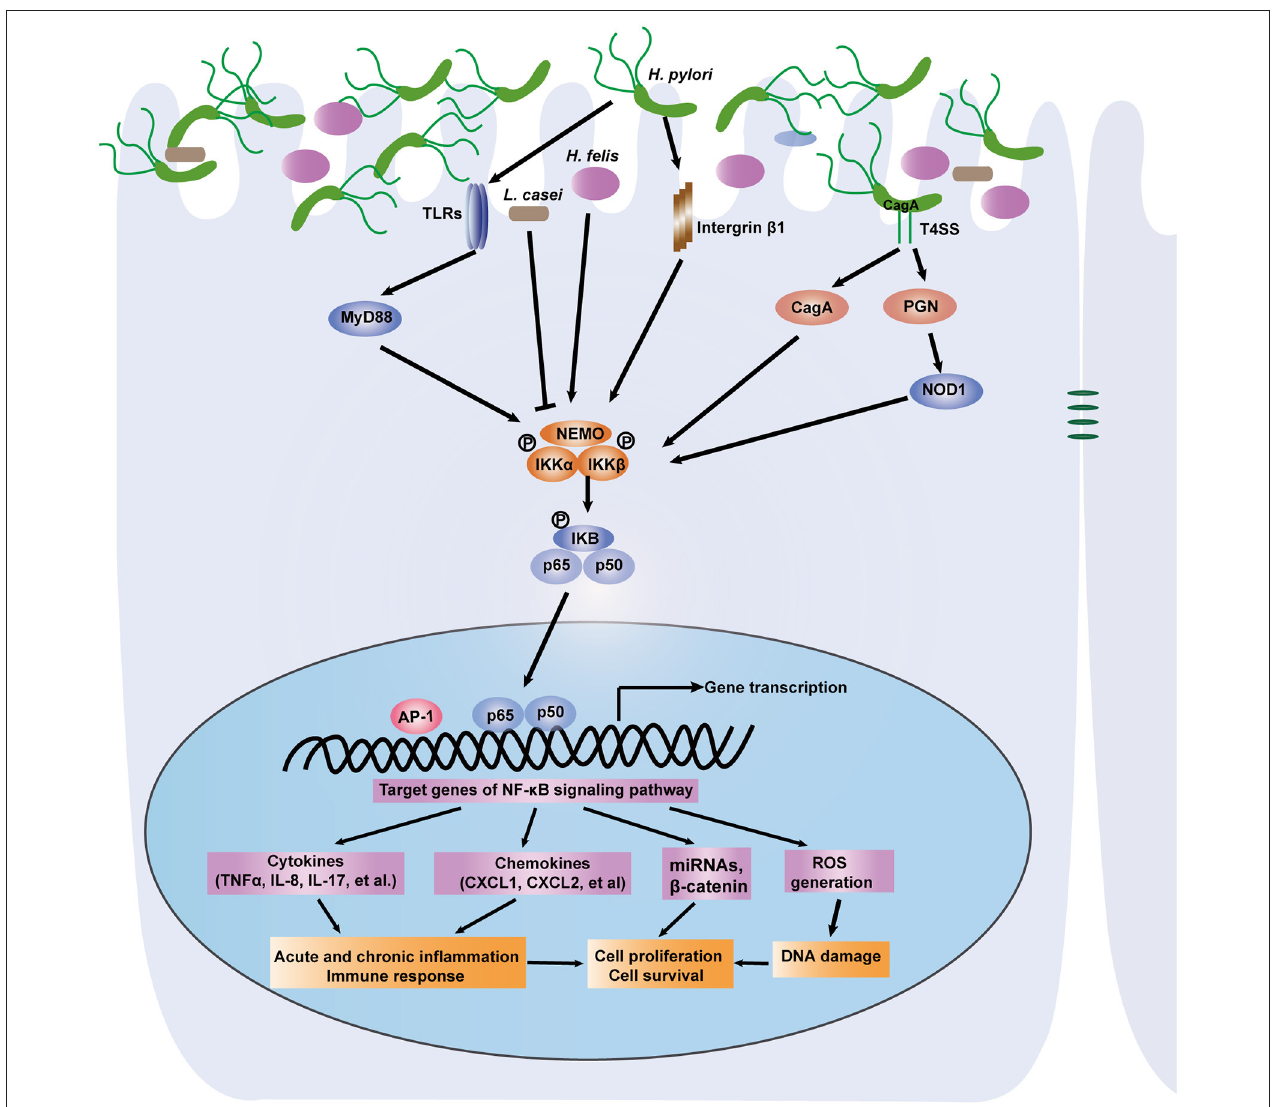
FIGURE 2 | A depiction of the modulation of NF- κ B signaling pathway by gastric microbiota, especially H. pylori . Gastric epithelial cells PRRS (NOD1, TLRs) specifically recognize the virulence factors such as CagA and peptidoglycan that are delivered by the H. pylori cag pathogenicity island. Then the NF- κ B pathway is activated through IKK-mediated phosphorylation of I κ B. Active NF- κ B translocate to nucleus and induce downstream genes expression. NF- κ B activation promotes acute, chronic inflammation and immune response via induction of cytokines and chemokines. The accumulation of DNA damage is associated with activation of the NF- κ B signaling pathway. Several miRNAs and other genes can be activated. As a result, H. pylori infection induces gastric carcinogenesis via regulation of cell proliferation and survival. Other microorganisms including L. casei and H. felis link the NF- κ B pathway to gastric inflammation and